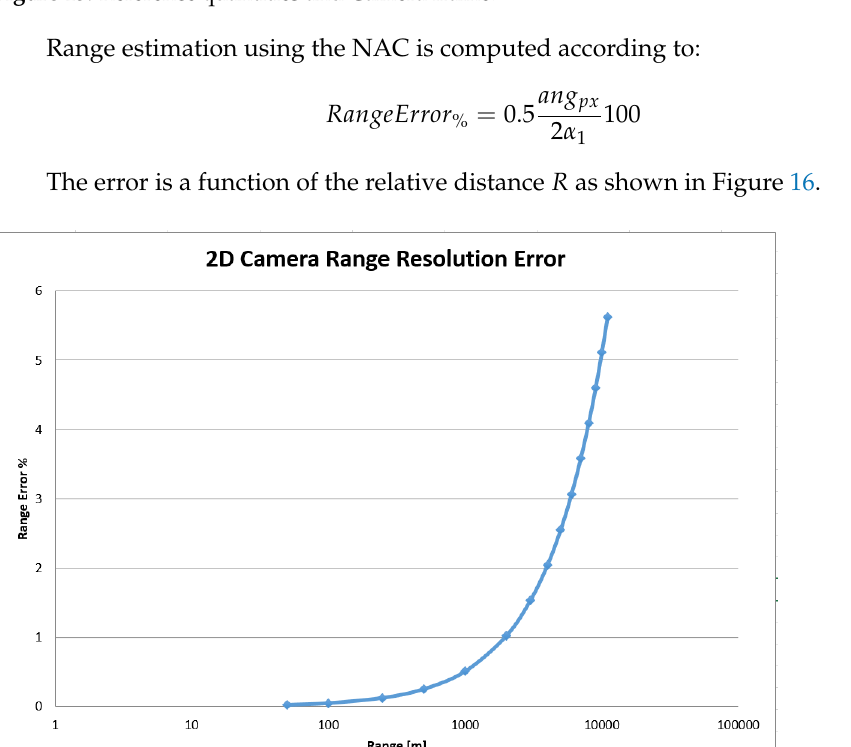
Figure 15. Reference quantities and Camera frame.